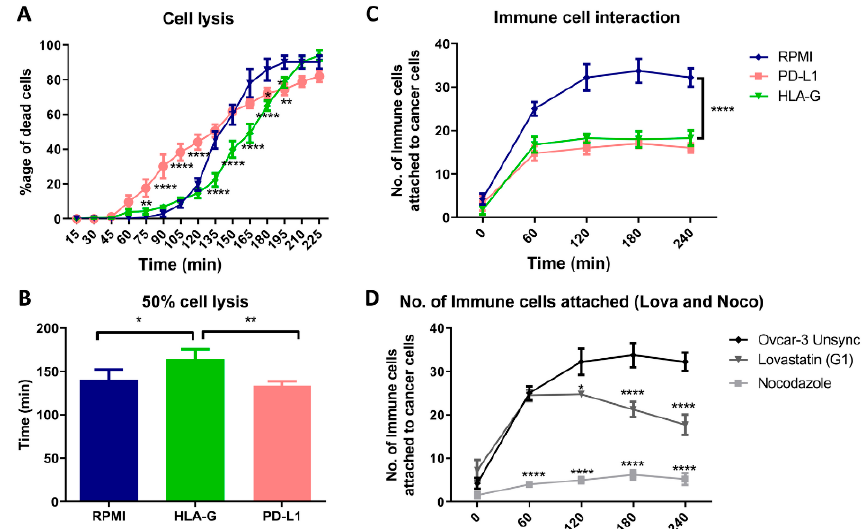
Figure 6. Co-culture of OVCAR-3 cells with PBMCs. ( A ). Time-dependent lysis of OVCAR-3 cells in RPMI medium compared to presence of HLA-G and PD-L1. PD-L1 initially increases the lysis, while HLA-G resulted in delayed lysis of the cancer cells compared to OVCAR-3 cultured in absence of two proteins. ( B ). HLA-G increased the time required for the lysis of half of the population, but no di ff erence with PD-L1. ( C ). PD-L1 and HLA-G, both decreased the attachment of the immune cells as a decrease in total number of cells attached to the cancer cells. ( D ). We found that the interaction between immune cells and mitotic cells (nocodazole) was significantly low compared to G1-synchronized cells (lovastatin) or unsynchronized cells.